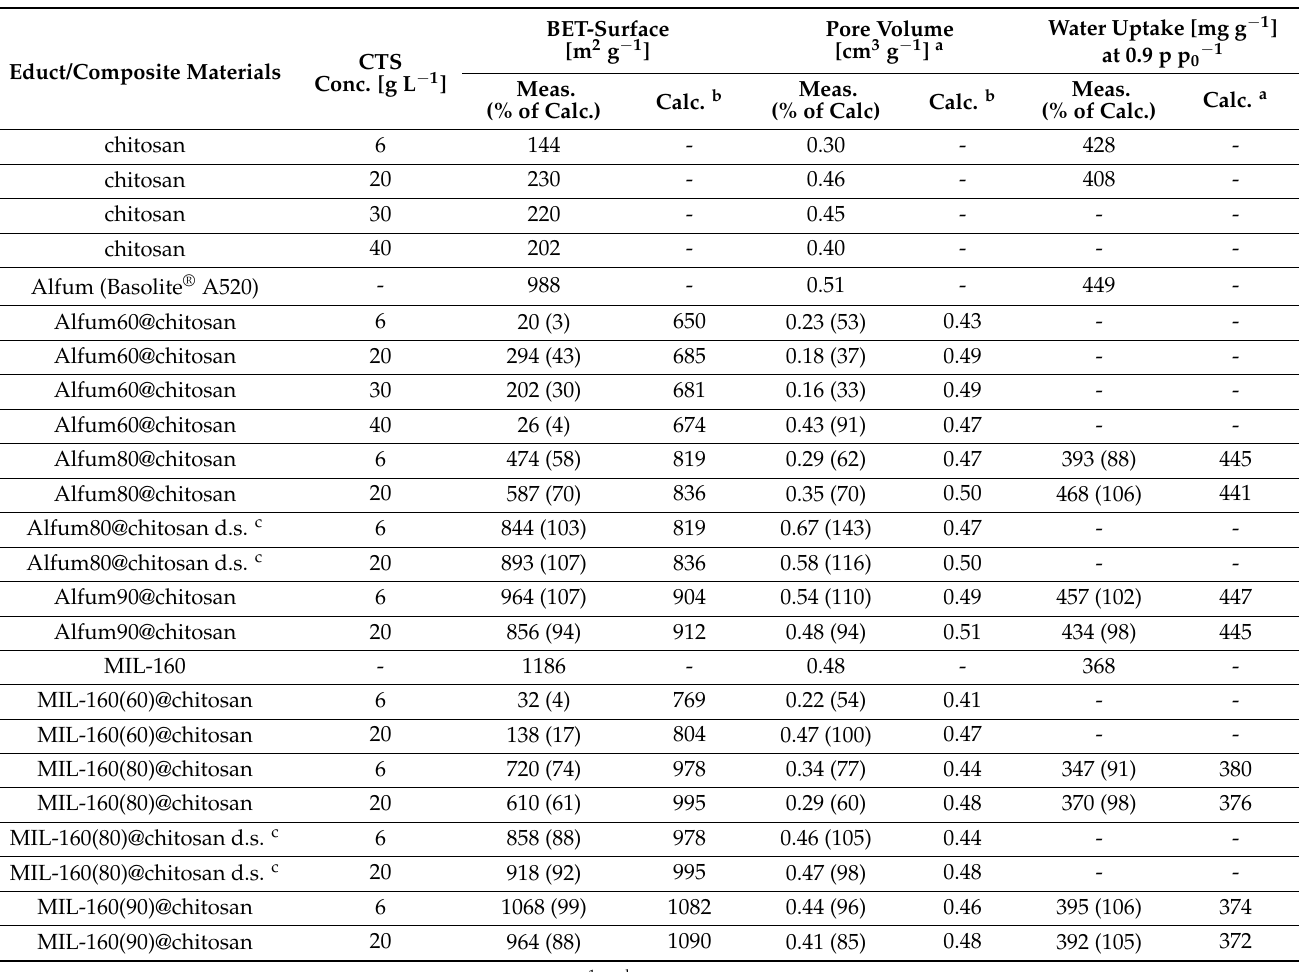
Table 3. BET-surface areas, pore volumes, and water uptake values of the composite materials and the